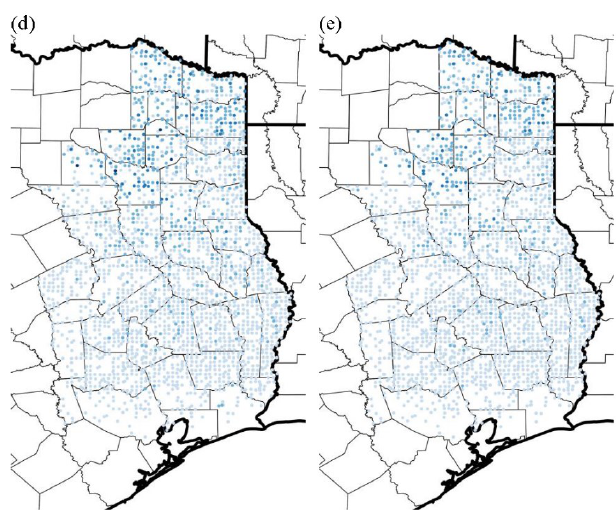
Figure 5. Estimated probabilities of invasion by Japanese honeysuckle in plots sampled in eastern Texas as part of the Forest Inventory and Analysis Program of the USDA Forest Service assuming ( a ) current conditions, ( b ) artificial regeneration on 25%, ( c ) 50%, ( d ) 75%, or ( e ) 100% of the plots (chosen at random).